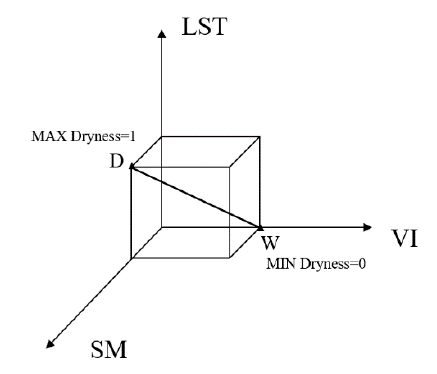
Figure A1. The definition of the TVMDI. TVMDI is based on VI, LST, and SM as the axis of the three-dimensional space. The TVMDI is defined as the square root of the square sum of VI, LST, and SM [34].